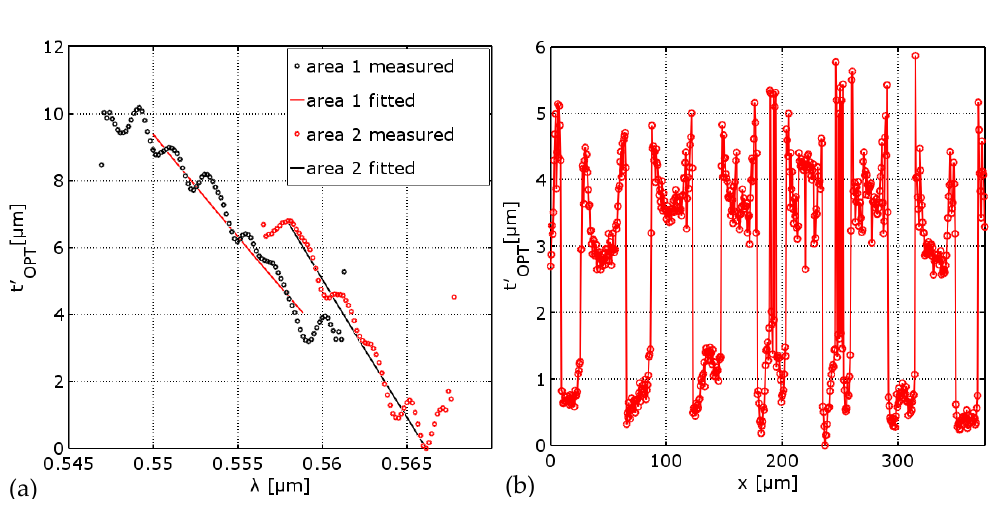
Figure 2. Result of the measured RDOT ( a ) for two separate areas with different cross-linking amounts over a spectral range and ( b ) spatially resolved along one sample